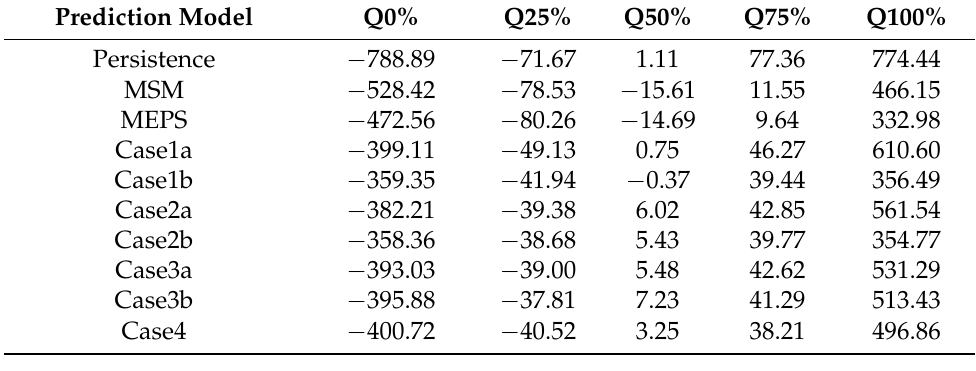
Table 3. Quantile of the forecast error. Quantile values are in W · m − 2 .